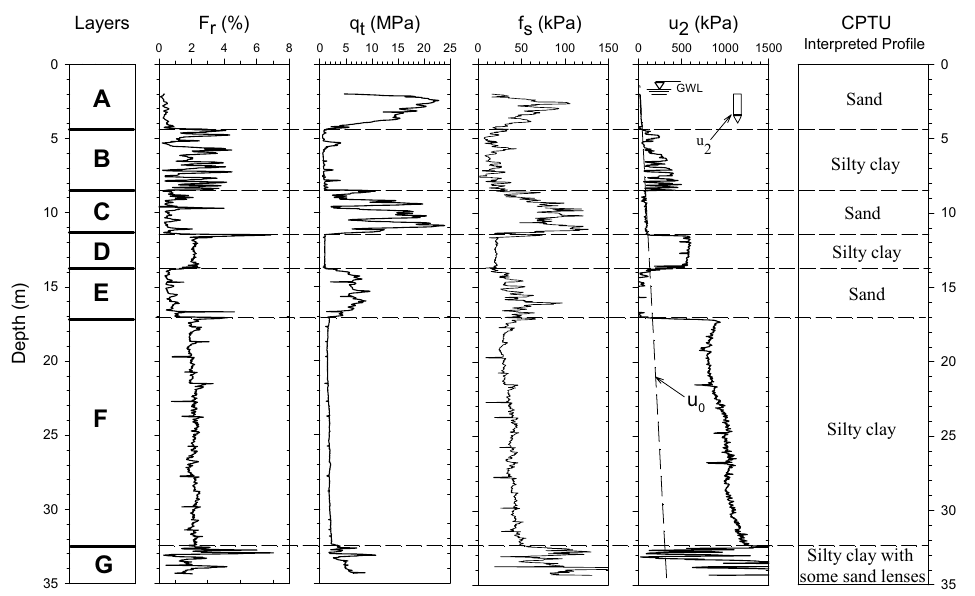
Fig. 5 – Piezocone test results for Caravelas region and the identification of seven main layers.